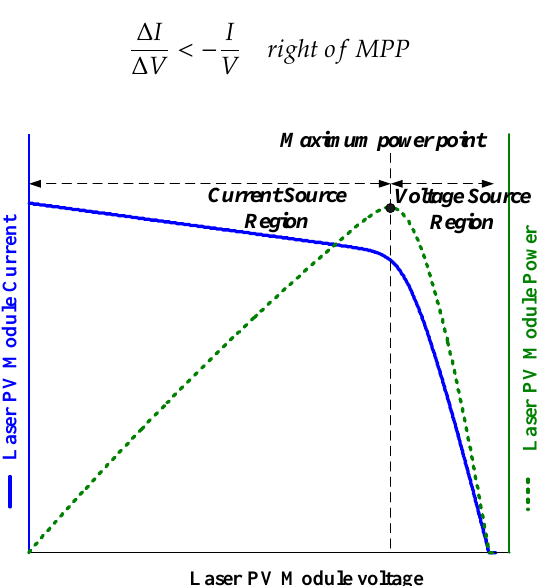
Figure 12. Characteristic curve of the laser PV module.